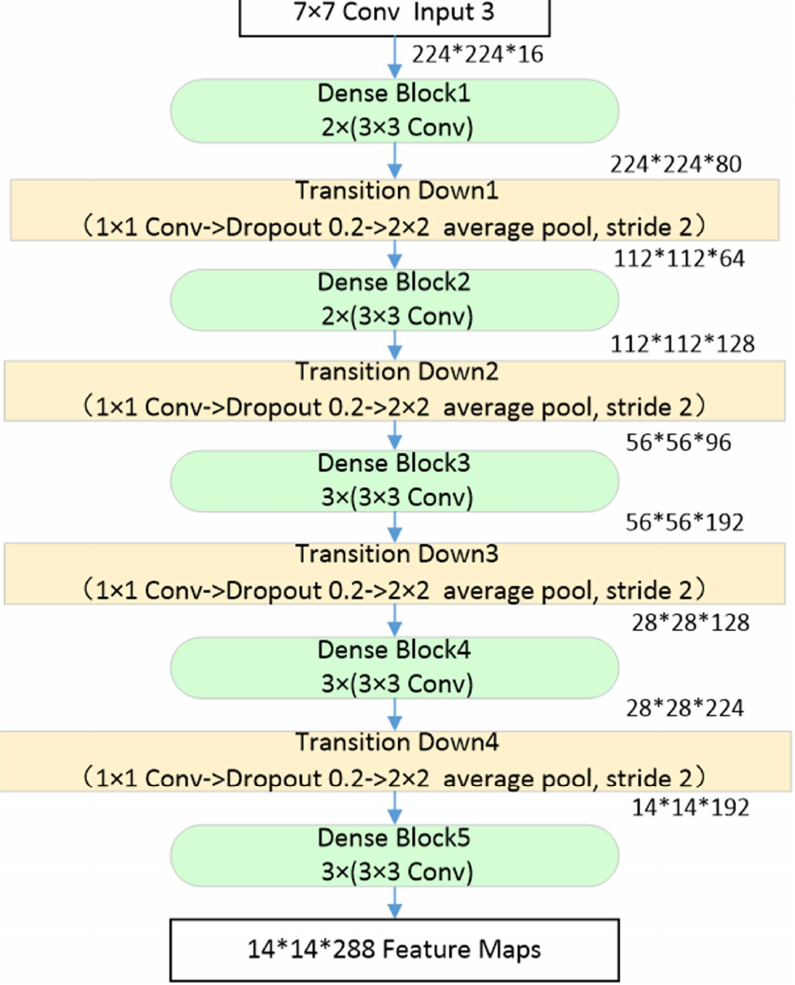
Figure 2. The lightweight DenseNets architectures. The growth rate for all networks is k = 32. Note that each “conv” layer shown in the figure corresponds to the sequence Batch